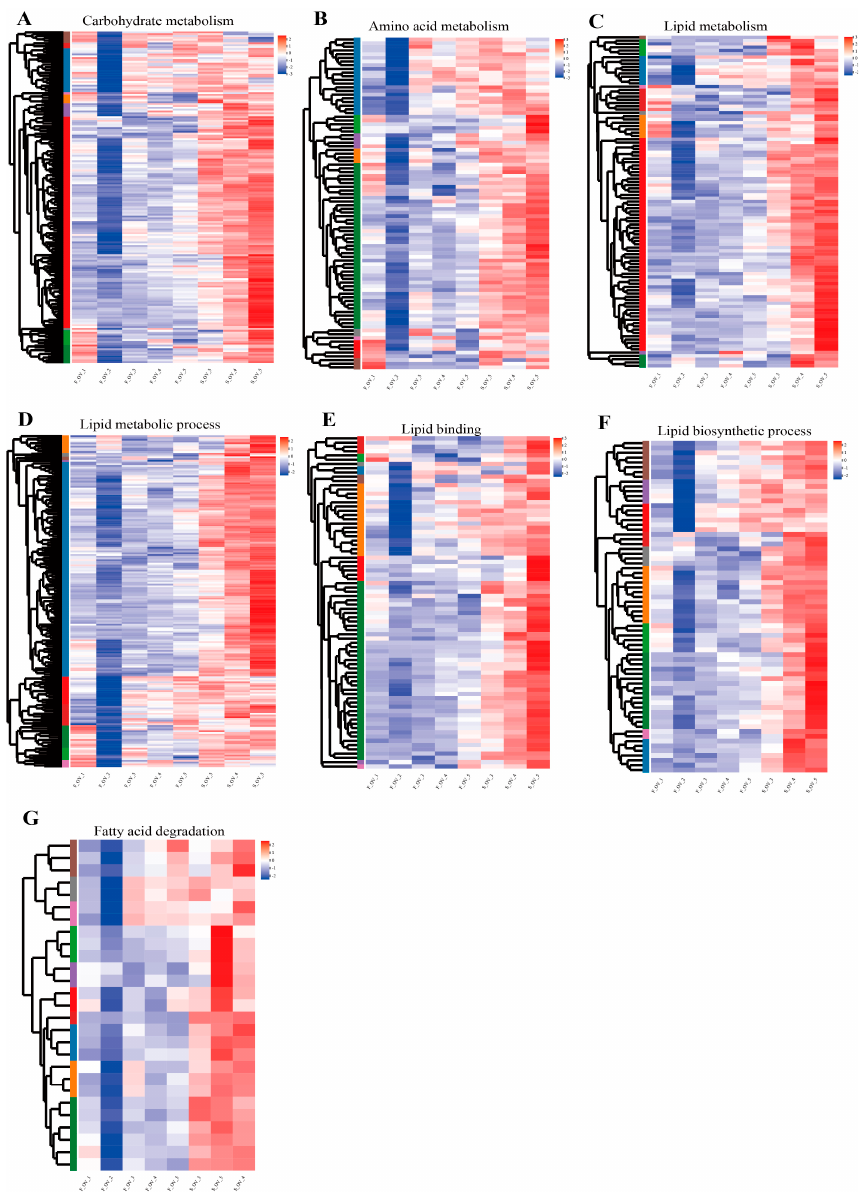
Figure 5. Heatmap analysis of the expression of metabolism-related genes during different ovarian stages. KEGG analysis of three metabolic pathway unigenes of up- and down-regulated during different ovarian stages: ( A ) Carbohydrate metabolism; ( B ) Amino acid metabolism; ( C ) Lipid metabolism. GO analysis of lipid metabolism-related genes up- and down-regulated during different ovarian stages: ( D ) Lipid metabolic process (GO: 0006629); ( E ) Lipid binding (GO: 0008289); ( F ) Lipid biosynthetic process (GO: 0008610). KEGG analysis of three lipid metabolism pathway genes of up- and down-regulated during different ovarian stages: ( G ) Fatty acid degradation (map00071).